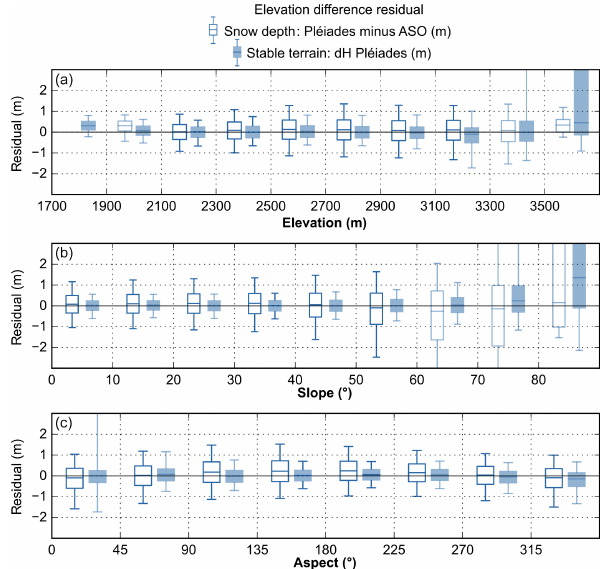
Figure 7. Distribution of the residuals between the Pléiades and ASO snow depth maps over the snow-covered area (empty box) and stable terrain (filled box) against elevations (a) , slopes (b) and aspect (c) . Over stable terrain, the ASO product is set uniformly to zero. Boxes where data were covering less than 1km 2 are slightly transparent.